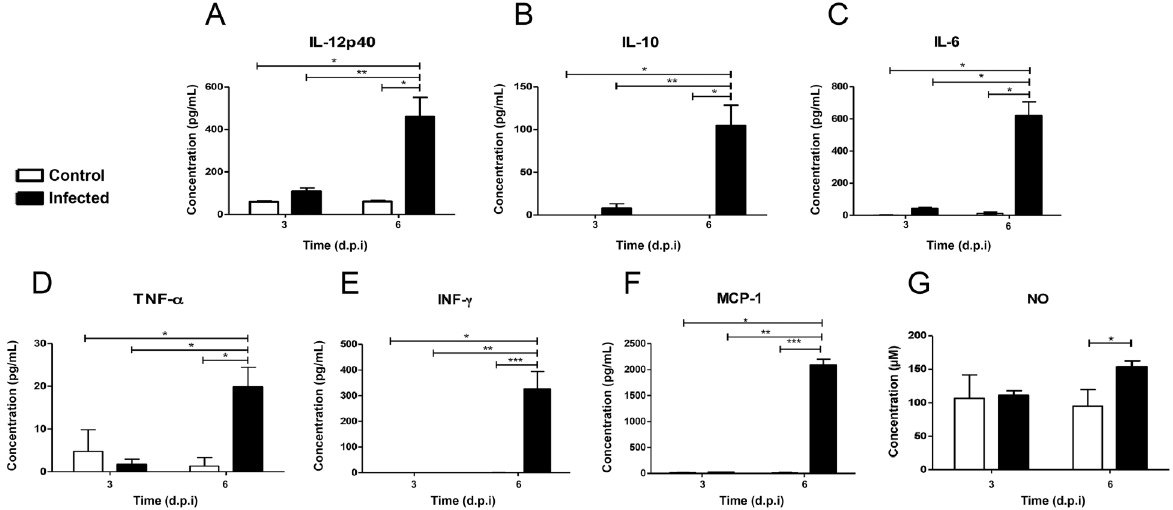
Figure 7. Expression of IL-12p40, IL-10, IL-6, TNF- a , INF- g , MCP-1, and NO in the supernatants of control and infected brain homogenates of mice at 3 and 6 d.p.i. (days post-infection). Data are reported as mean ± SD. *P o 0.001; **P o 0.01; ***P o 0.05 (two-way ANOVA and Bonferroni post-test for multiple